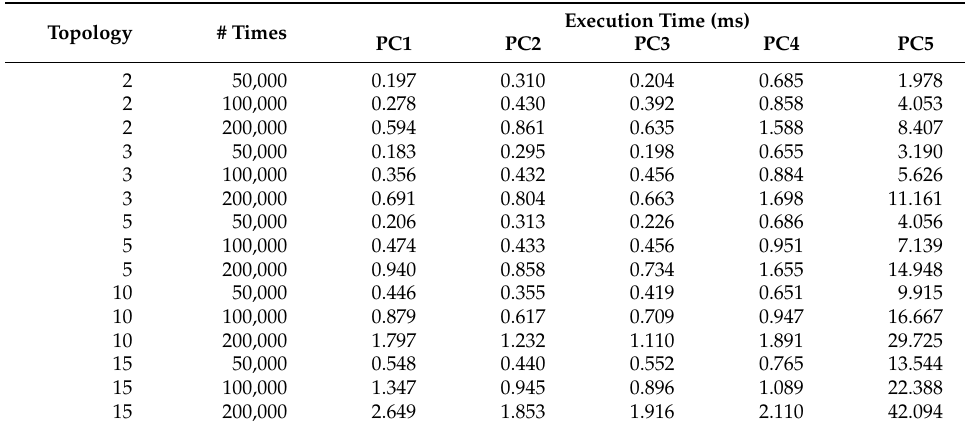
Table 7. Performance evaluation of parallel generic block.